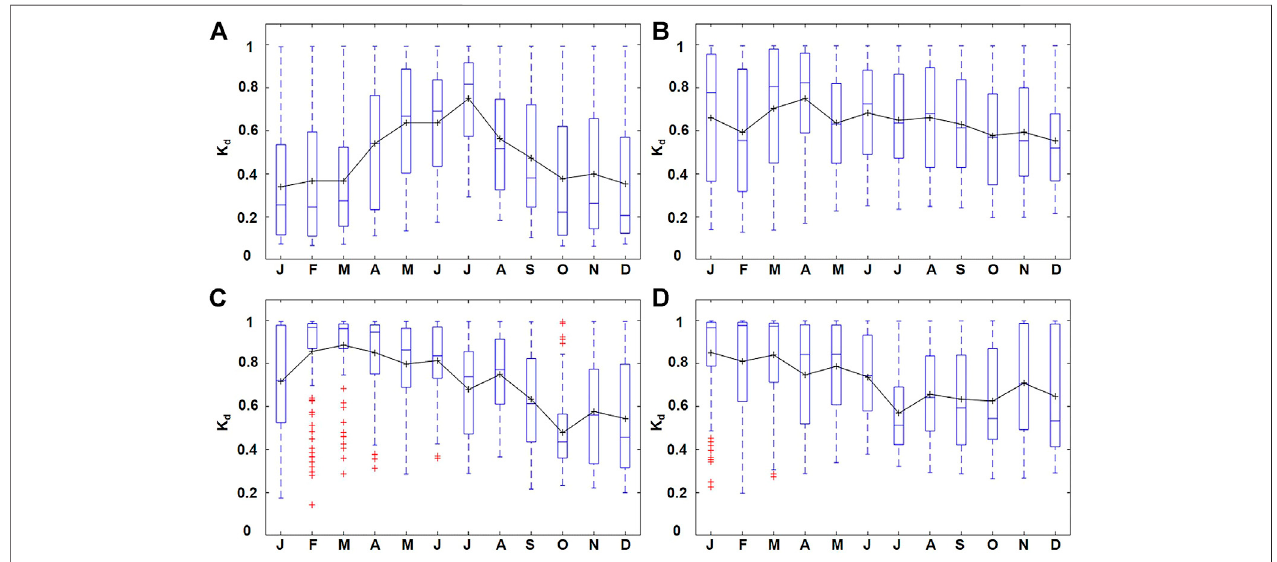
FIGURE 5 | The monthly variations in K d simulated at four forest sites. (A – D) are Cha, Qia, Din and MPM sites, respectively.